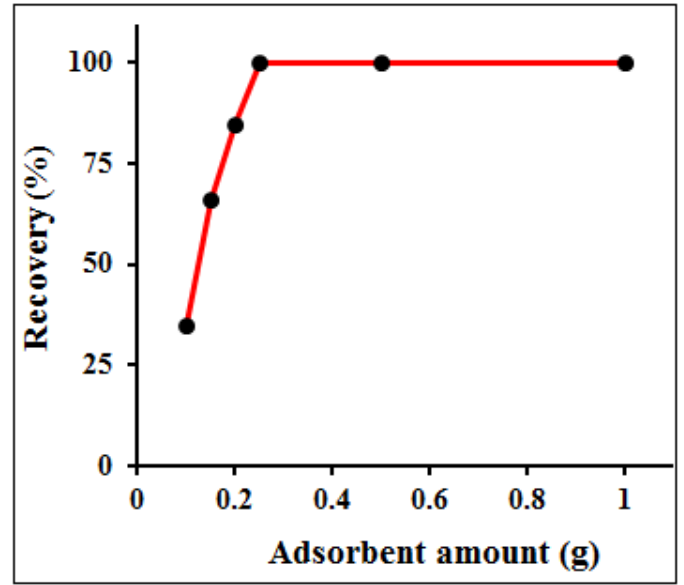
Figure 9. Effect of adsorbent amount on the adsorption of Hg(II) (experimental conditions: sample